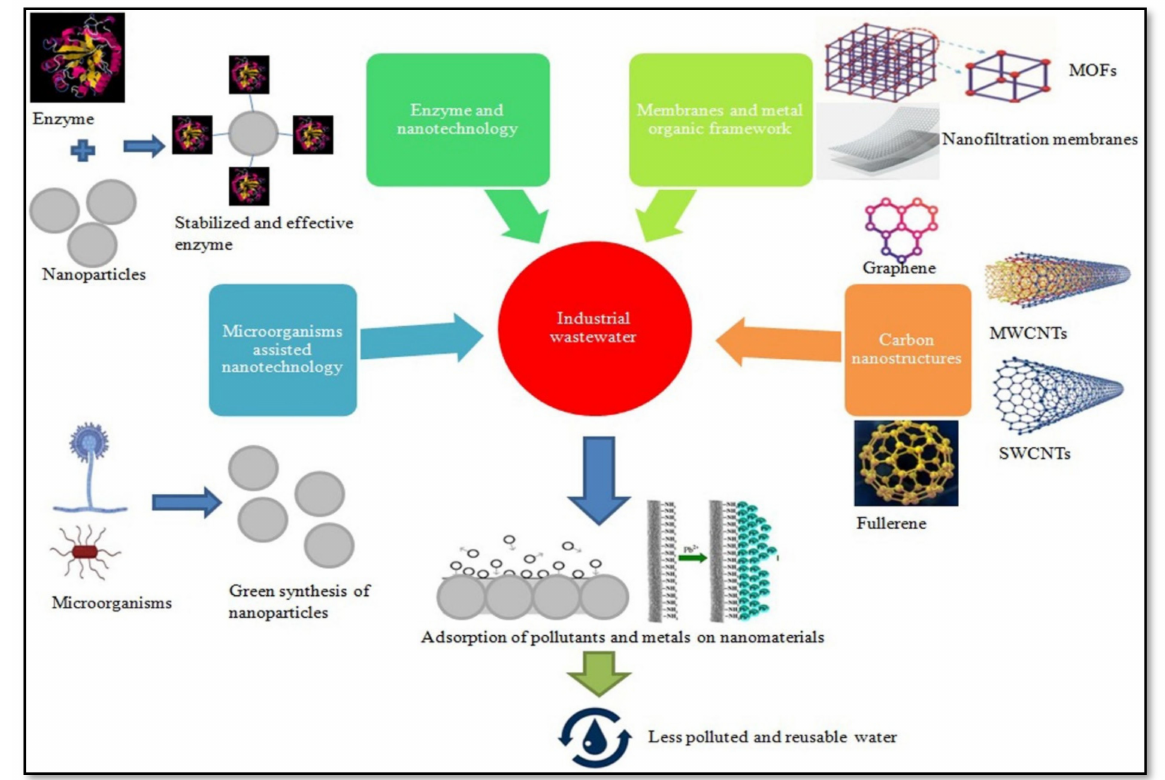
Figure 6. Remediation of industrial wastewater using a nanocatalyst